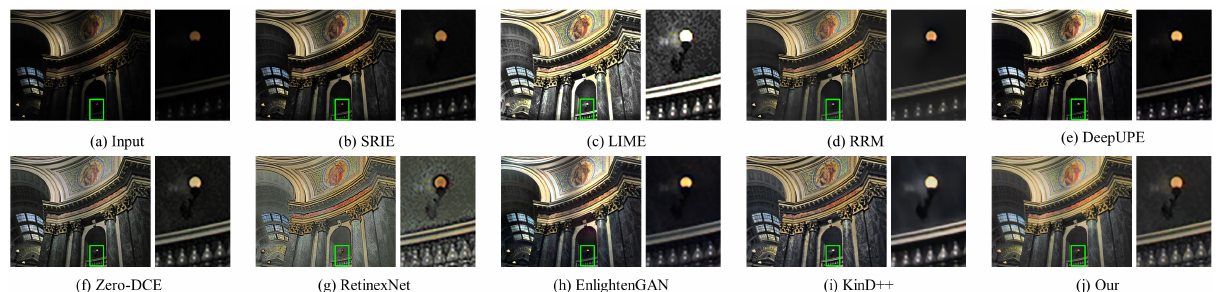
Figure 5. Visual comparison of low-light image enhancement on an image from the LIME dataset.